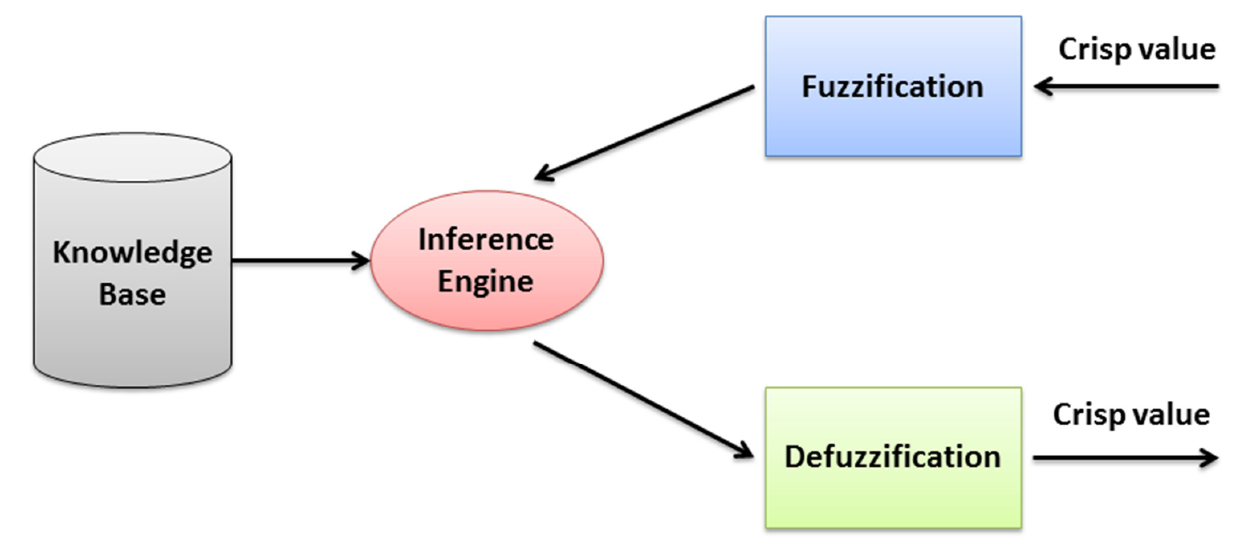
Figure 2. Structure of a fuzzy inference system.